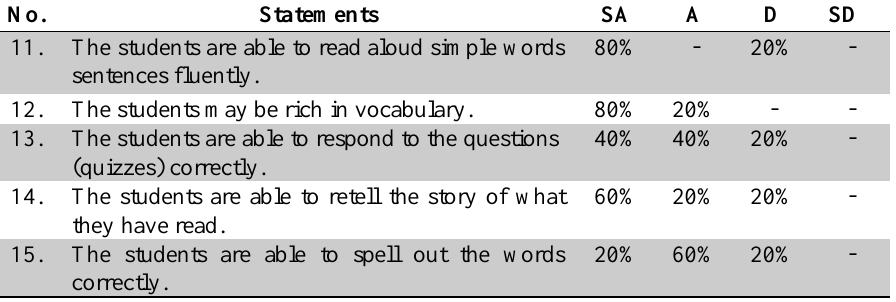
Table 2. The Effects of Implementing the Effective Techniques of Teaching